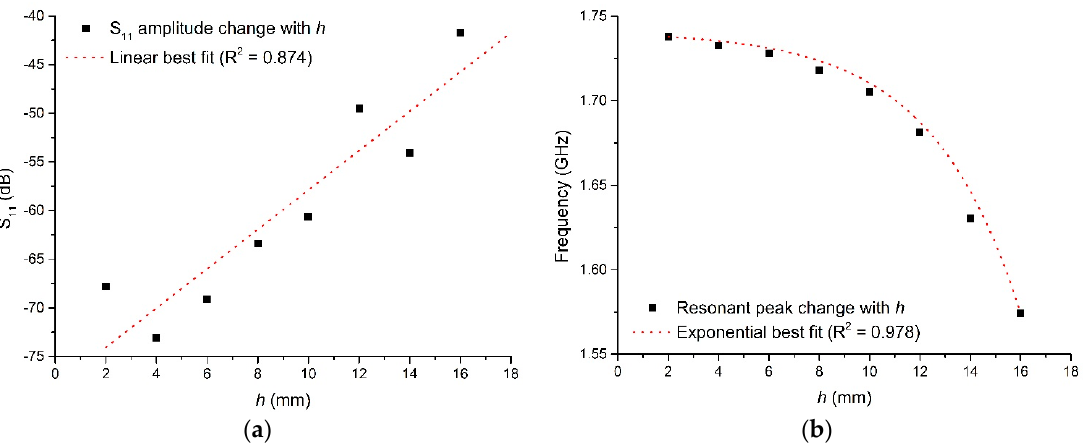
Figure 3. Cavity response when varying sample height, h , for ( a ) the S 11 signal amplitude, and ( b ) the frequency at which the resonant TE 010 mode occurs.